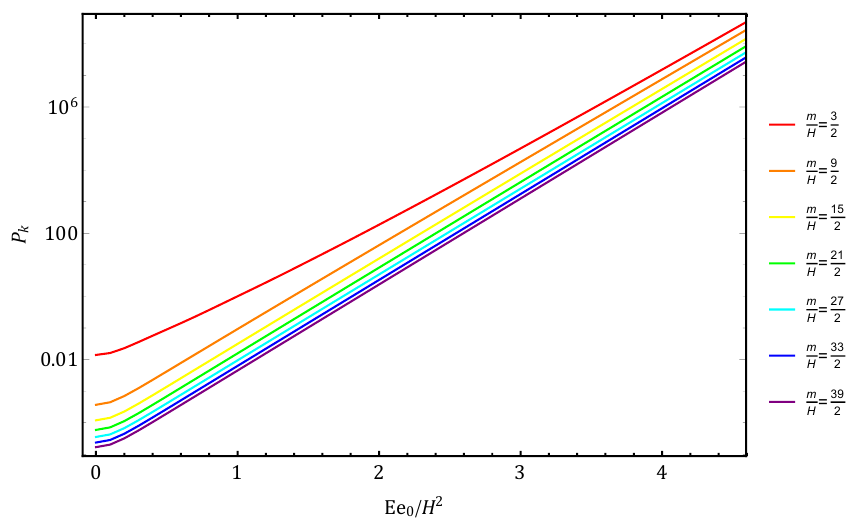
Figure 5 . We set k = 1 and the mass of the massive (cid:12)eld to be 3 H= 2 ; 9 H= 2 ; 15 H= 2 ; 21 H= 2 ; z =k 27 H= 2 ; 33 H= 2 ; 39 H= 2 respectively. The power spectrum increases exponentially with respect to the electric (cid:12)eld strength.